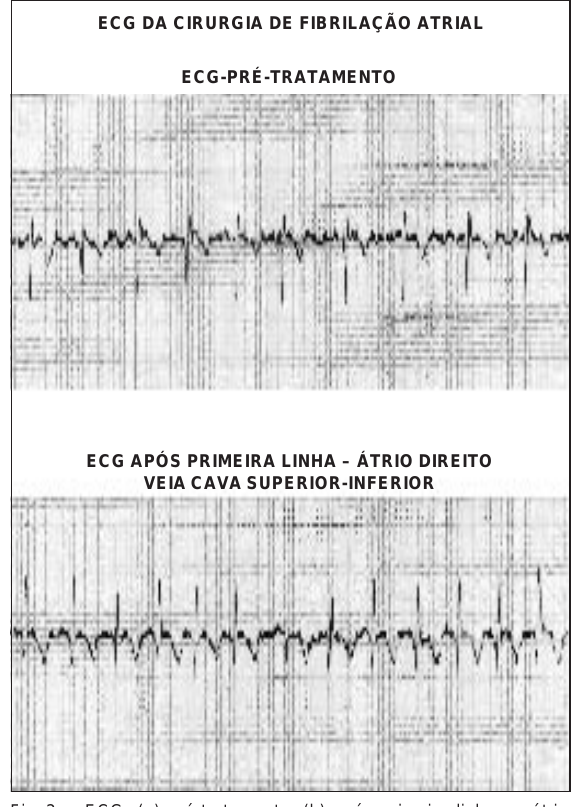
Fig. 2 - ECG. (a) pré-tratamento; (b) após primeira linha no átrio direito: veia cava superior-inferior.